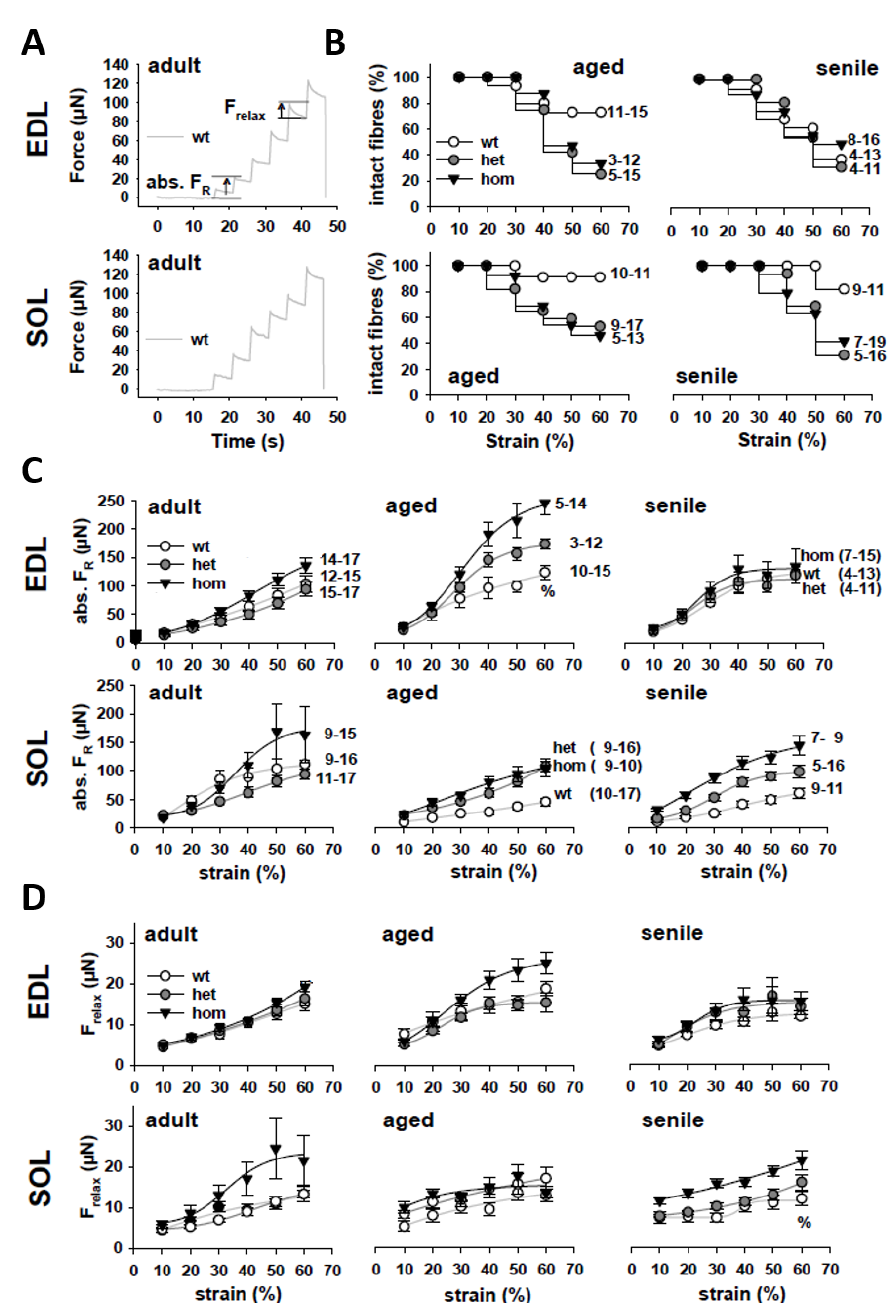
Figure 4. Visco-elastic behavior of single muscle fibers from EDL and SOL muscle carrying the R349P desmin mutation during aging. ( A ) Representative examples of quick stretch-jump experiments, stretching adult EDL and SOL fibers in 10% bins to 160%L 0 . ( B ) Kaplan–Meier survival plots demonstrate a worsened stretch resistance of mutant fibers. ( C ) Group analysis of F R across ages in EDL (top) and SOL (bottom) fibers shows increased absolute restoration force levels in mutants over wt fibers for almost all ages and in both muscles. ( D ) Force relaxation amplitudes with stretch suggest almost similar viscous relaxation with a tendency for higher viscous relaxation in mutant fibers over the wt. Significance tested with two-way ANOVA followed by post hoc analysis (Bonferroni). Error bars: standard